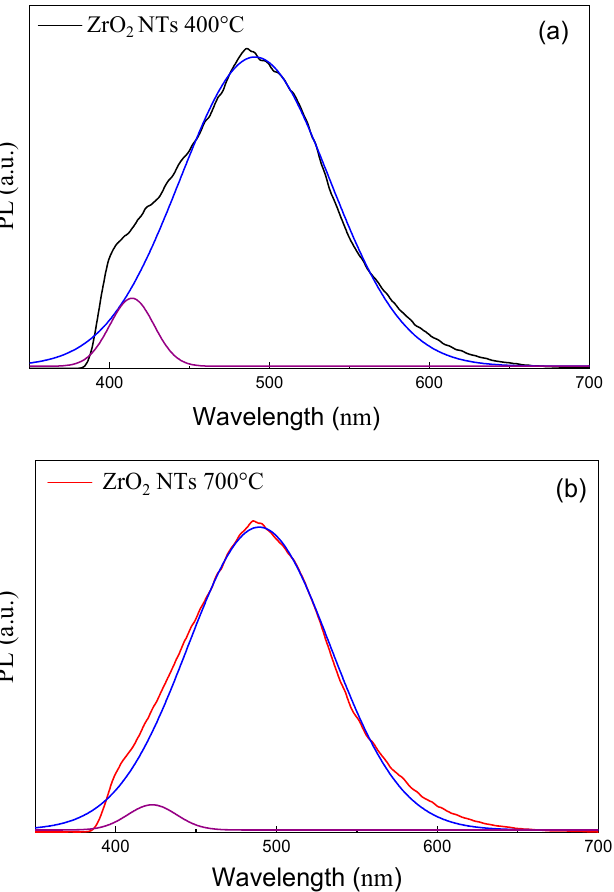
Figure 7. Deconvolution of the PL band spectrum of ( a ) 400 °C- and ( b ) 700 °C-annealed ZrO 2 NTs. Salah et al. [35] attribute the broad peak centered on 490 nm to a self-activated luminescence originating from the asymmetry and unusual oxygen coordination of zirconium in monoclinic ZrO 2 . The PL intensity increased with the annealing temperature, while the peak centered at 420 nm became smaller in comparison with the PL peak centered at 490 nm. This result can be explained by the increasing oxygen defects with the increase in annealing temperature and also by the crystallographic phase transformation